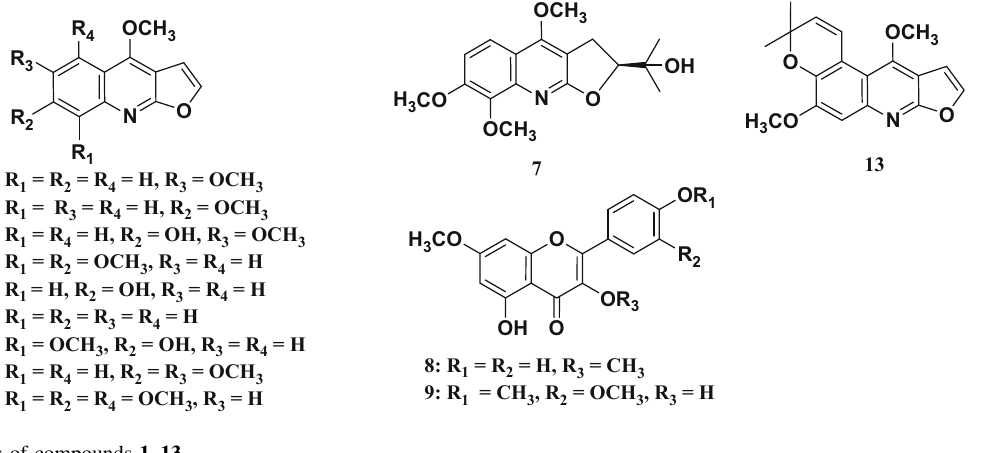
Fig. 1 Structures of compounds 1 –